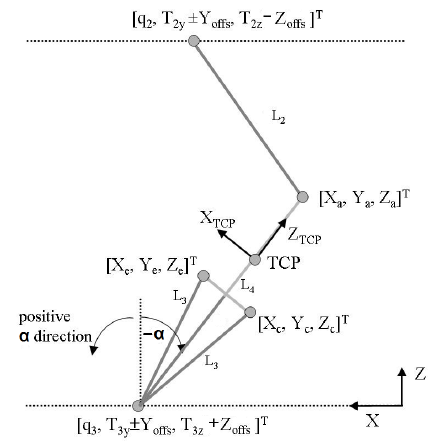
Figure 7: Kinematic parameters in XZ-plane.